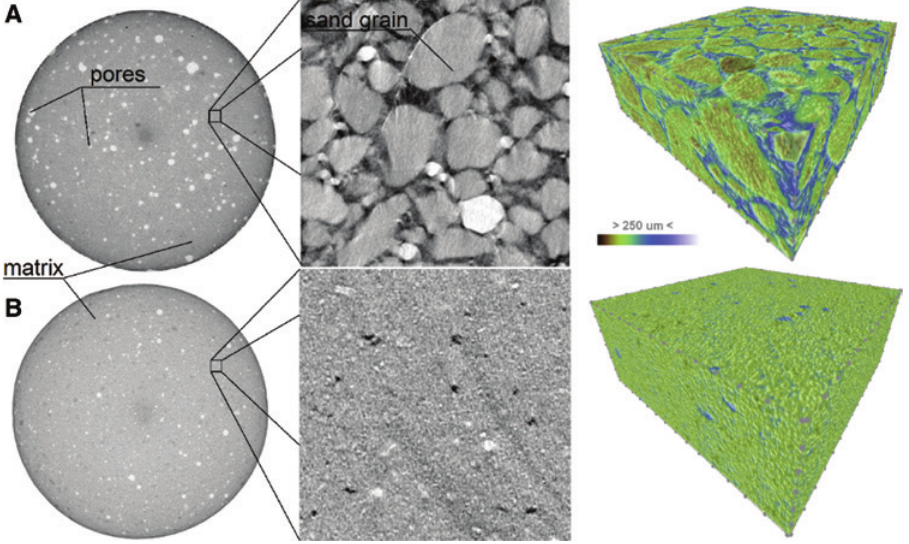
Figure 6: Microstructure of the investigated materials and 3D reconstruction; results for (A) mortar and (B) gypsum (inverted